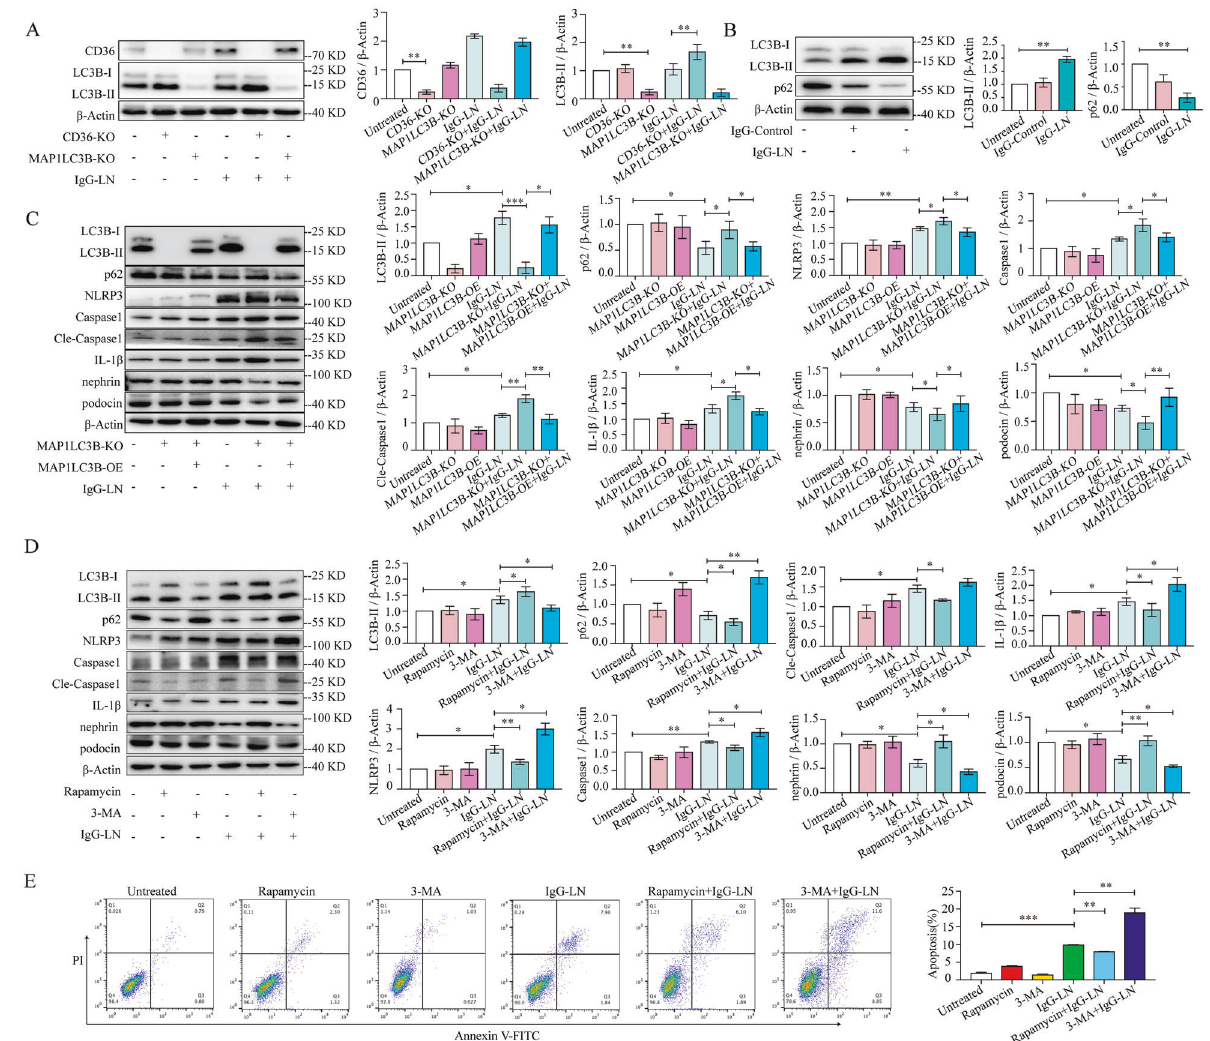
Fig. 4 Enhancing autophagy could reduce NLRP3 in fl ammasome activation and podocyte injury. A The regulatory relationship between CD36 and MAP1LC3B was explored by CRISPR/Cas9 technology and subsequent western blot analysis. B Western blotting of autophagy markers LC3B and p62 in human podocytes with treatment of IgG-LN (500 μ g/ml; 72 h), compared to no treatment (Untreated vs. IgG-LN). C Western blot analysis of LC3B, p62, Nephrin, Podocin, NLRP3, Caspase1, Cleaved-Caspase1, and IL-1 β in human podocytes under different treatments (Untreated vs. IgG-LN; IgG-LN vs. MAP1LC3B KO + IgG-LN; MAP1LC3B KO + IgG-LN vs. MAP1LC3B KO + MAP1LC3B OE + IgG-LN). D Western blot analysis of LC3B, p62, Nephrin, Podocin, NLRP3, Caspase1, Cleaved-Caspase1, and IL-1 β in human podocytes under different treatments (Untreated vs. IgG-LN; IgG-LN vs. rapamycin + IgG-LN; IgG-LN vs. 3-MA + IgG-LN). E Representatives of Annexin V - PI double-staining in different groups and quantitative of apoptosis was shown in histogram with mean ± SD from 3 experiments (Untreated vs. IgG-LN; IgG-LN vs. rapamycin + IgG-LN; IgG-LN vs. 3-MA + IgG-LN). Cle-Caspase1: Cleaved-Caspase1. Data are expressed as the mean ± SD. * p < 0.05. ** p < 0.01. *** p <